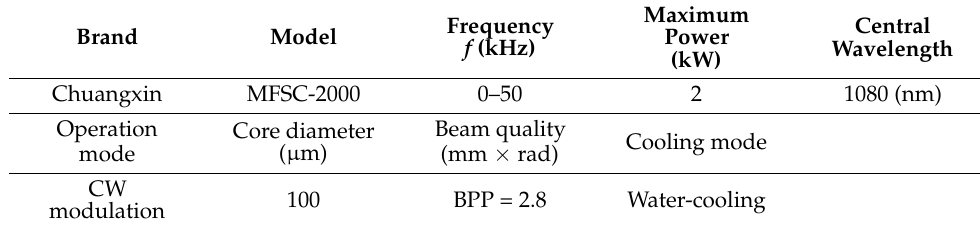
Table 2. Parameters of the laser equipment.